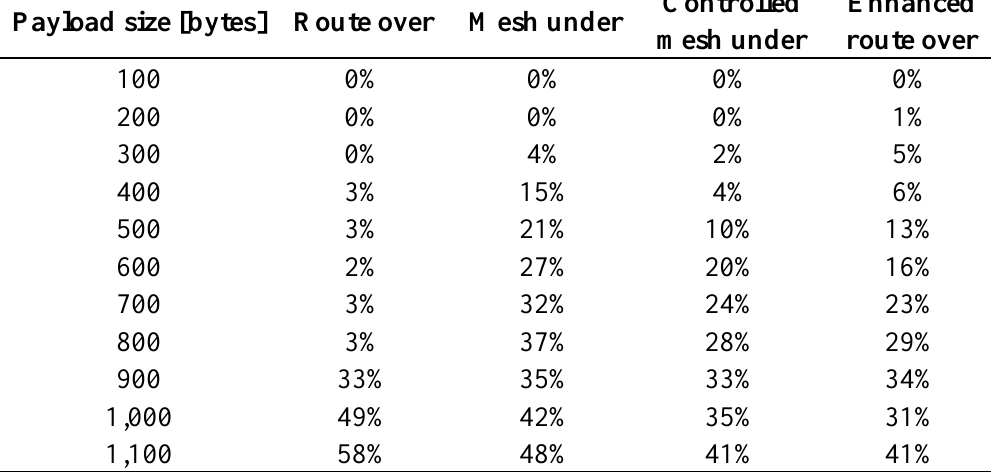
Table 1. Packet loss percentage. Route over proves to be more robust to packet loss than the other techniques. However, starting from a payload size of 900 bytes, buffer congestion causes a rapid worsening of route over packet loss. Link retransmissions due to collisions are the main cause of packet loss for mesh under, controlled mesh under and enhanced route